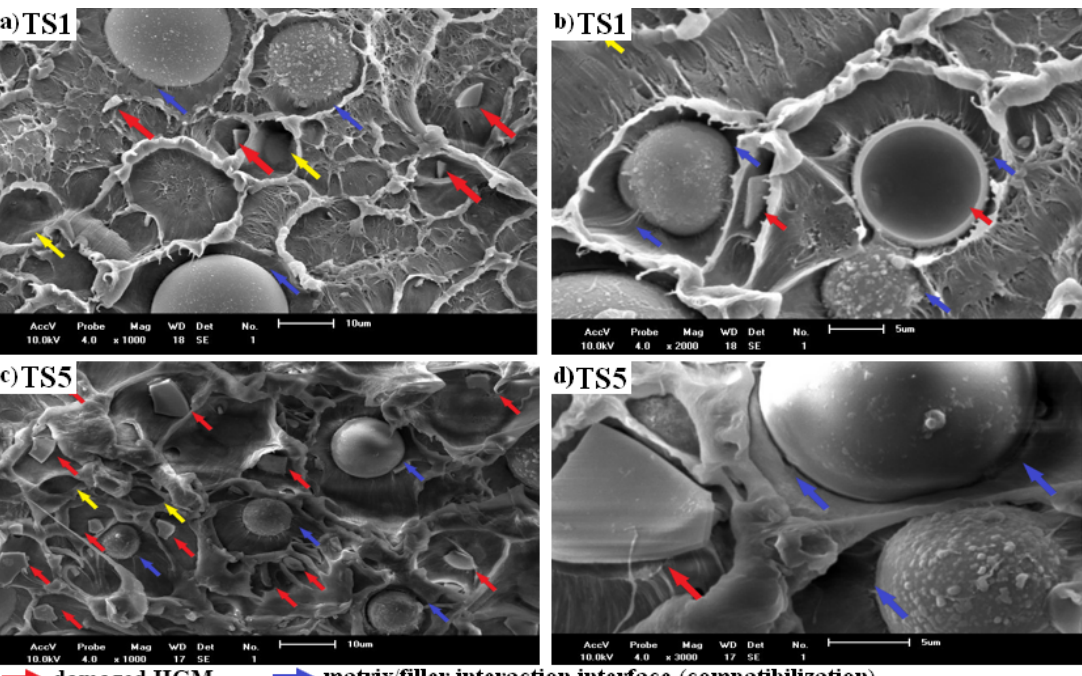
Figure 3. Photomicrographs of the systems via twin screw extruder